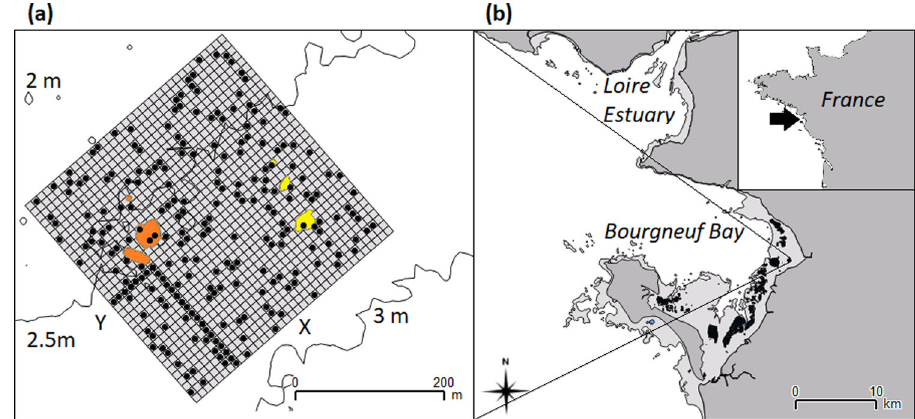
Fig. 1 Location of the study grid within Bourgneuf Bay covering two groups of oyster reefs (47°01 ’ 32 ” N, 2°00 ’ 26 ” W). a Shows the control (orange) and treatment (yellow) reefs and the superimposed study grid (edge length 350 m, individual cell edge 10 m) with selected cells for core sampling (black dots), bathymetry (contours), and ‘ X ’ and ‘ Y ’ axes of the grid labelled. Grid y -axis coordinates approximate bathymetry, Pearsons r = − 0.87). We used the inverse ‘ L ’ shape of samples near the southern corner of the grid for in situ quanti fi cation of MPB pigment composition and biomass to complete the remotely sensed MPB biomass estimates (NDVI; see Supplementary Results: Groundtruthing MPB for details). b Shows grid location in Bourgneuf Bay, showing intertidal areas (light grey), mainland (dark grey) and oyster farms (black). Inset panel shows location of Bourgneuf Bay (arrow) in the North Atlantic coastline of north-west France. Further illustrations in Echappé et al. 16